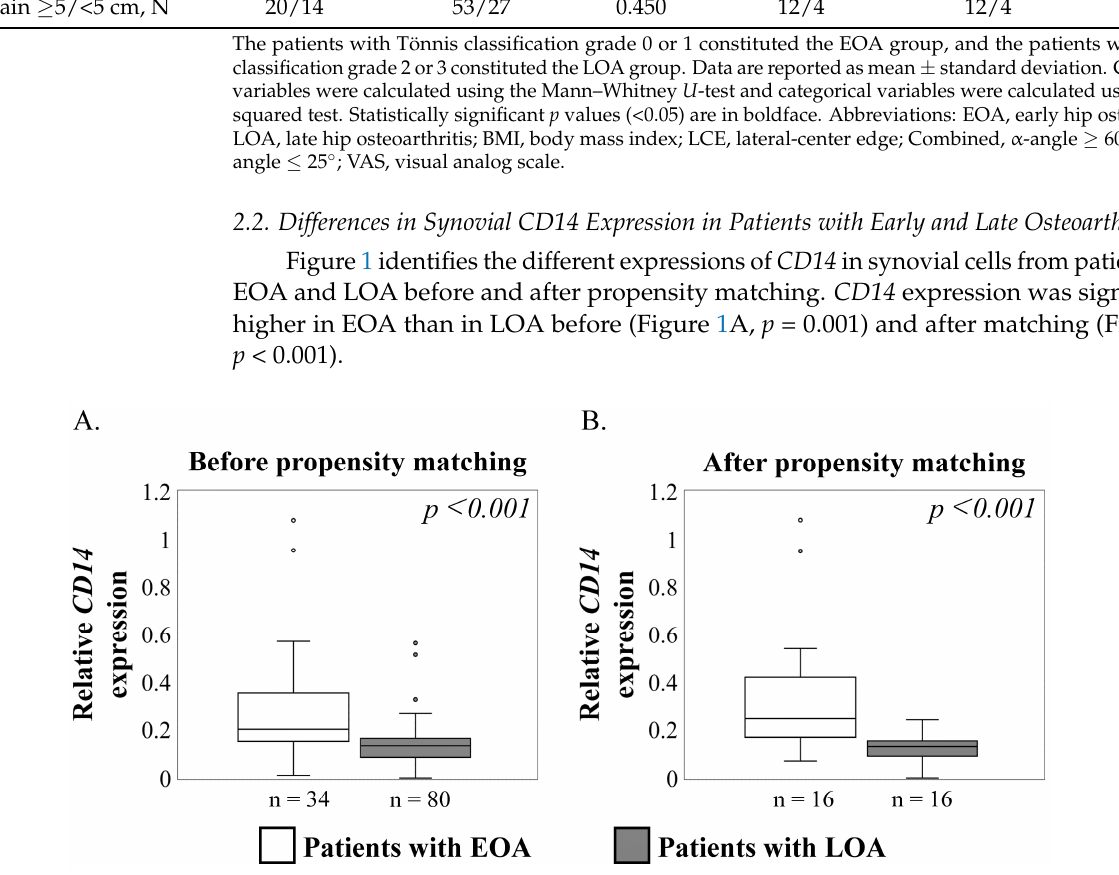
Figure 1. Comparison of synovial CD14 expression in patients with early and late hip osteoarthritis (EOA and LOA, respectively). Synovial CD14 expression in the before ( A ) and after ( B ) propensity matching cohorts. X axis: white and gray boxes represent the patients with EOA and LOA, respectively. Y axis: relative CD14 mRNA expression. The Mann–Whitney U -test was used for analysis. p < 0.05 indicates statistical significance. Boxes represent median and IQR (interquartile range, 25–75th percentiles); small circle represent values outside 1.5 × IQR.